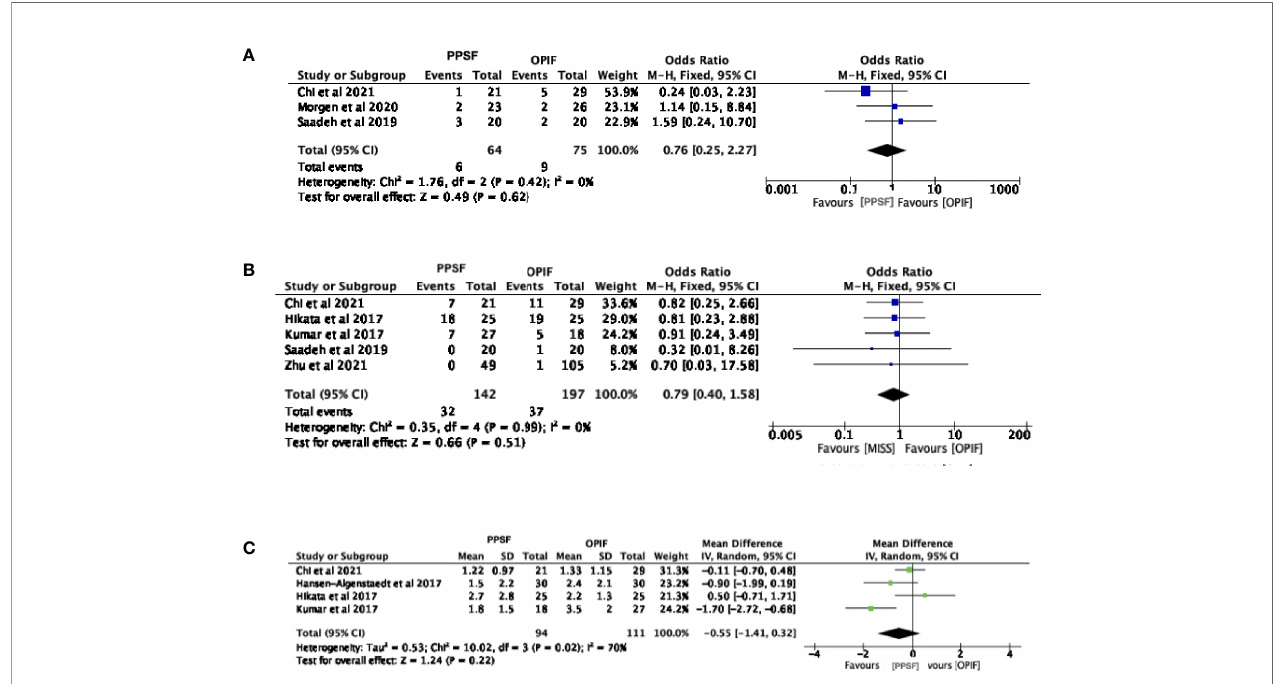
FIGURE 3 | Forest plots comparing clinical outcomes between Open posterior instrumented fusion (OPIF) and Percutaneous pedicle screw fi xation (PPSF). (A) Reintervention, (B) mortality, (C) postoperative pain. VAS, Visual Analogue Scale; SD, standard deviation; IV, inverse variance; CI, con fi dence